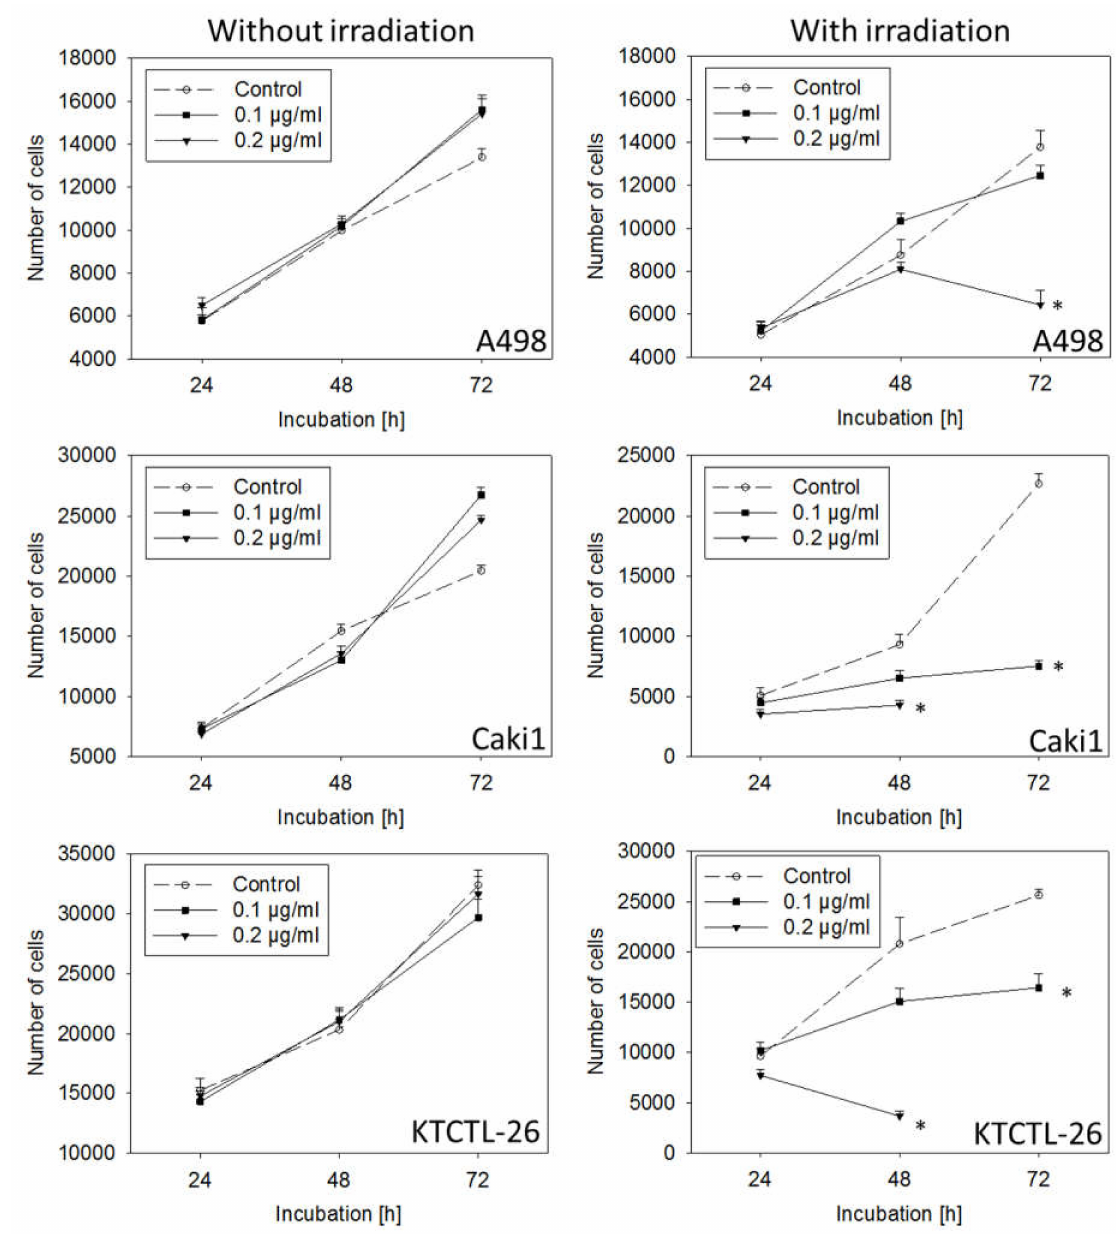
Figure 4. Growth of A498, Caki1, and KTCTL-26 renal cell cancer cells exposed to 0.1 or 0.2 µ g/mL curcumin without or with irradiation. Irradiation was done with 5500 lx visible light for 5 min. Following light exposure, curcumin-containing medium was replaced by medium without curcumin. Tumor cell number was then evaluated after 24, 48, and 72 h. Controls remained untreated. Each experiment was done in triplicate and repeated six times. Data from one representative experiment are shown.* Indicates significant difference to